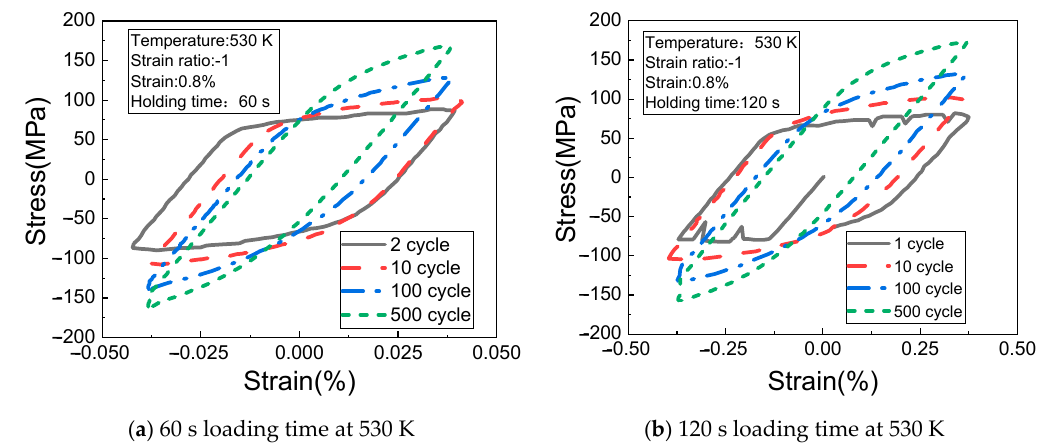
Figure 6. Results of different loading times at 530 K. ( a ) 60 s loading time at 530 K; ( b ) 120 s loading time at 530 K.